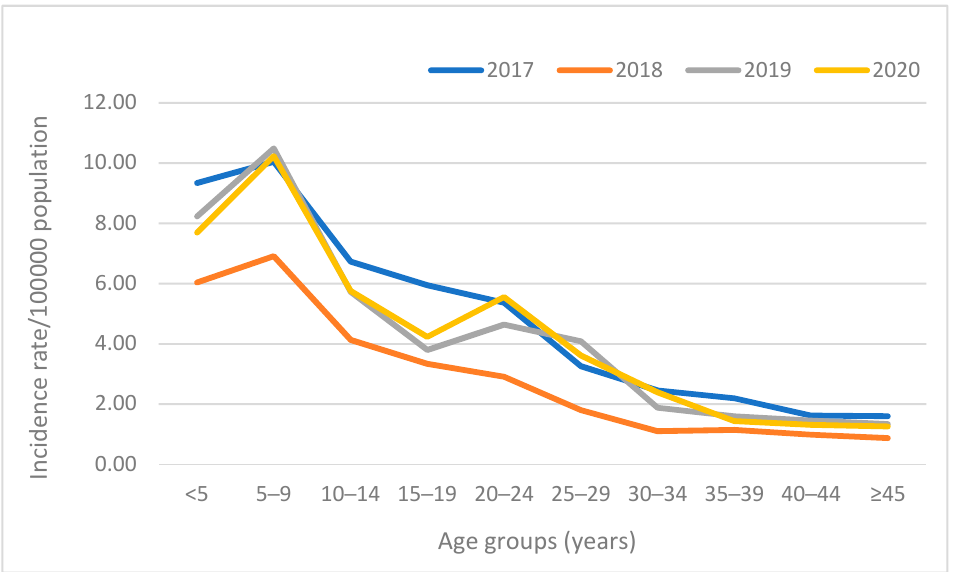
Figure 1. National age distribution of laboratory-confirmed hepatitis A cases per 100,000 population, 2017–2020.